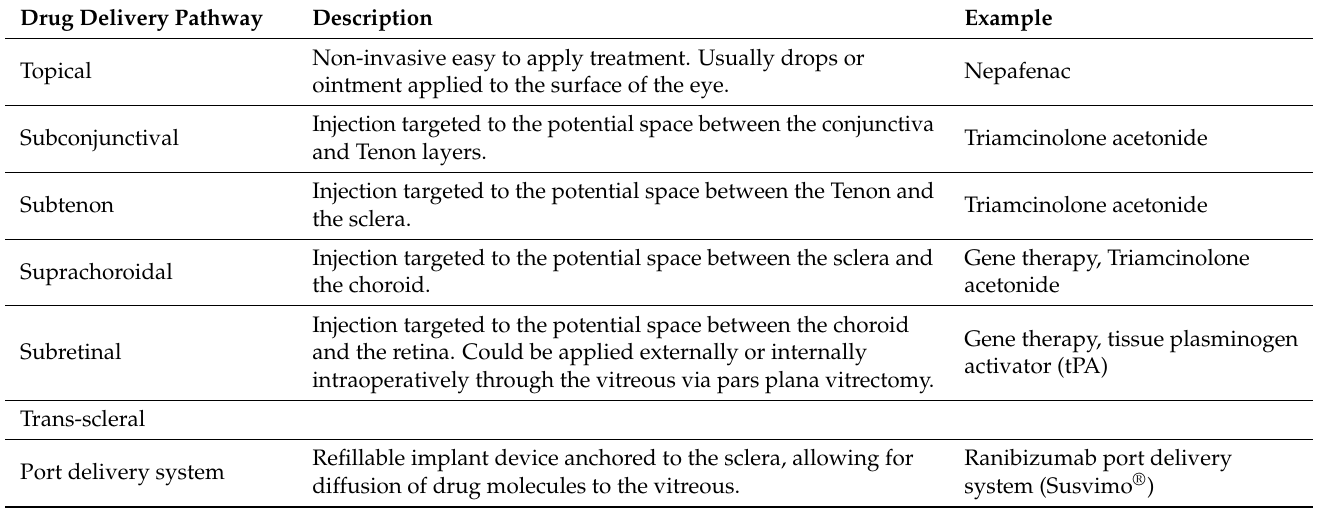
Table 2. Experience of drug delivery via various